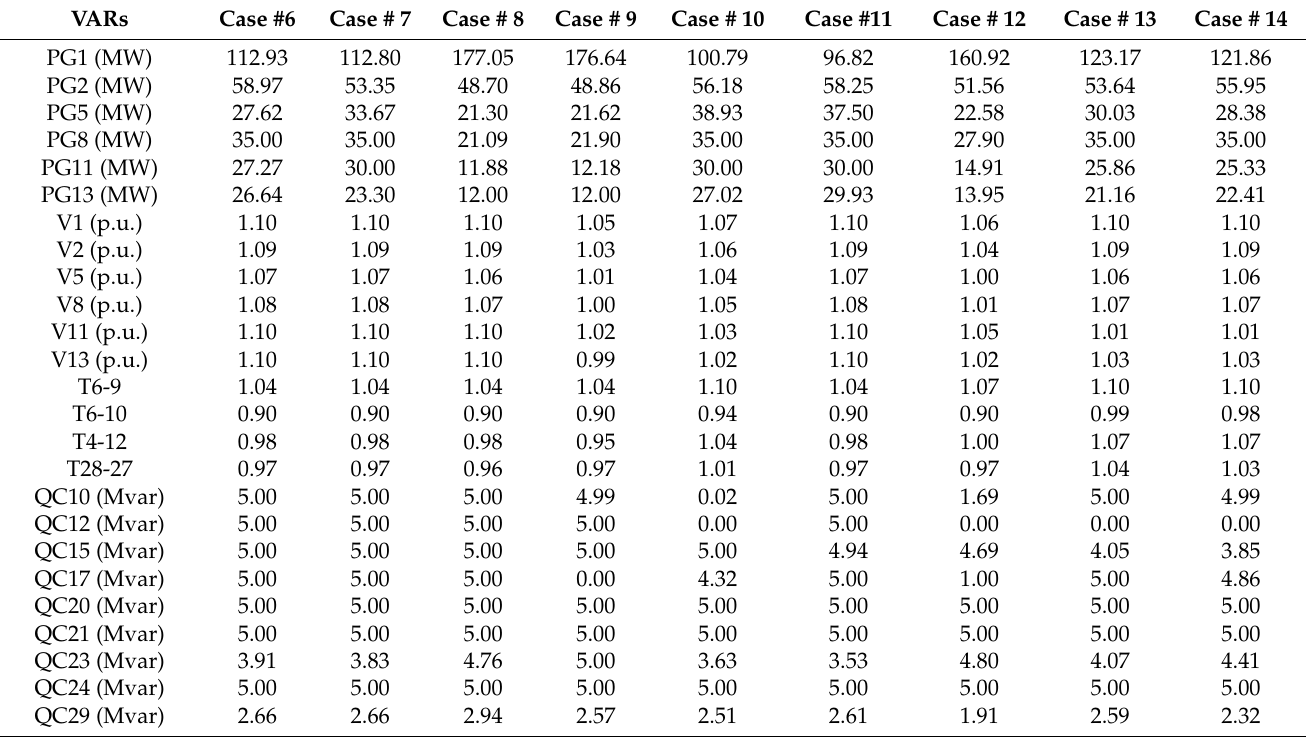
Table A2. Control variables of IEEE-30 bus system using TFWO algorithm for Cases